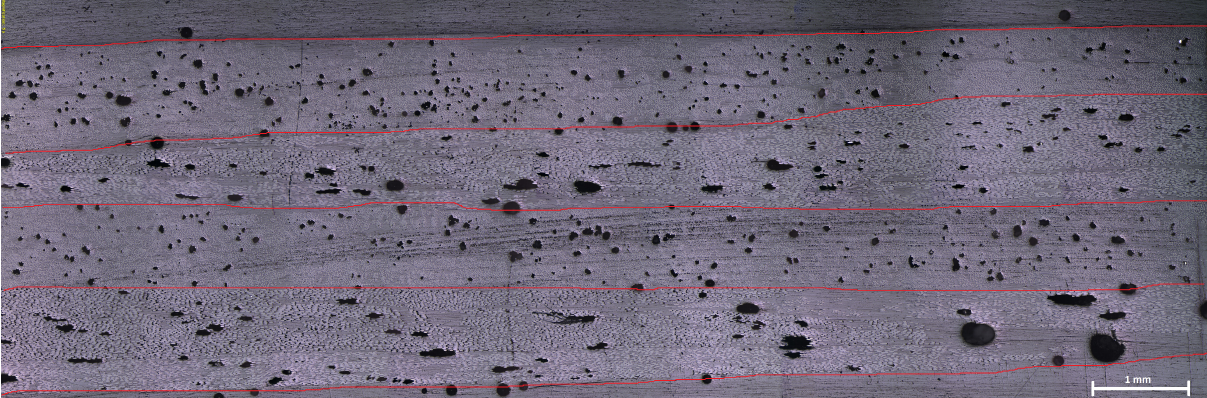
Figure 5: Microscopy of the pressure vessel.